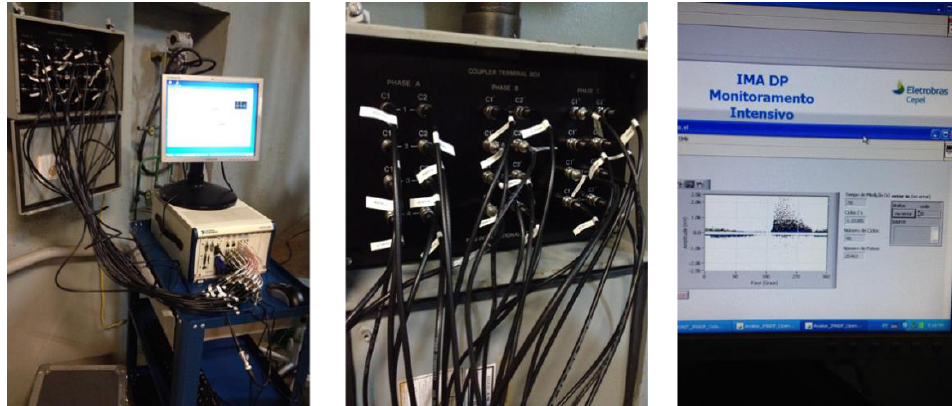
Figure 1. Measurement arrangement and screen displaying a PRPD resulting from the partial discharge measurement. discharge